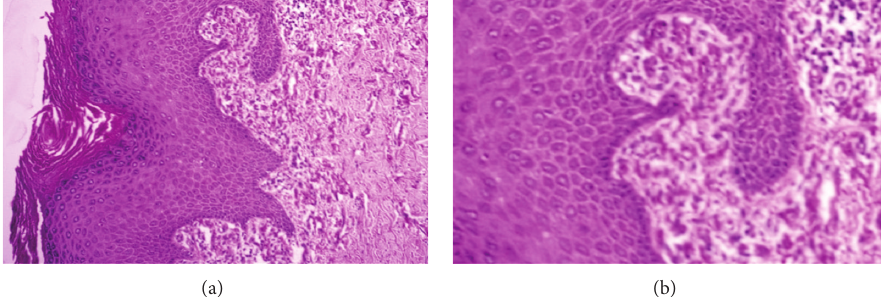
F 10: Perforating calci�c elastosis. Clumping of short elastic �bers in the dermis can be observed (a,